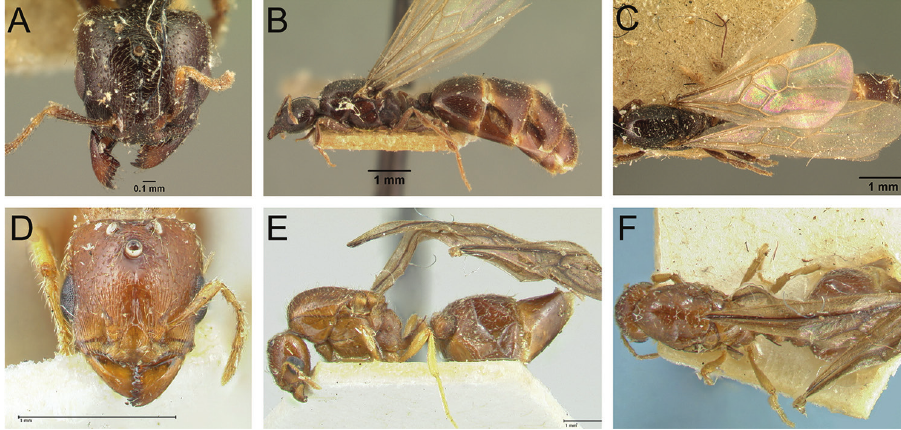
Figure 40. Carebara grandidieri -lectotype and Carebara voeltzkowi (= C . grandidieri syn. n.). Queen, CASENT0101999. A head in full-face view B body in profile view C body in dorsal view. Queen, CASENT0906665 D head in full-face view E body in profile view F body in dorsal